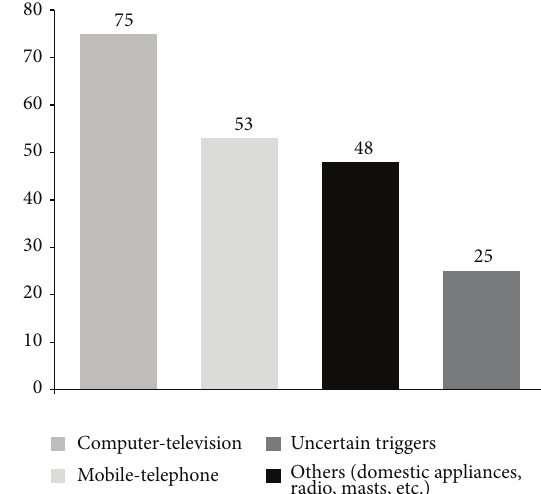
Figure 1: Electromagnetic field sources reported as symptom triggers in the group of patients self-reporting electromagnetic hypersensitivity (EHS, 𝑛 = 153 ). Data are expressed as percent of patients affected on the total number of